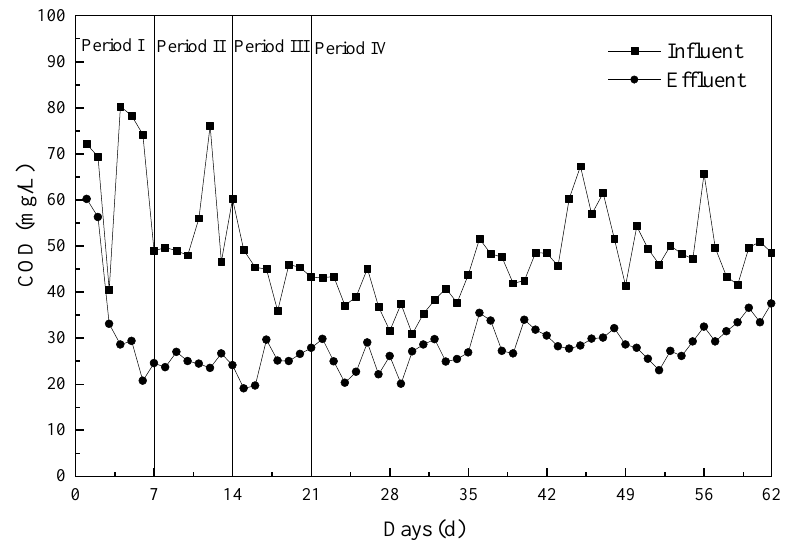
Figure 2. ALBR performance data for different periods.